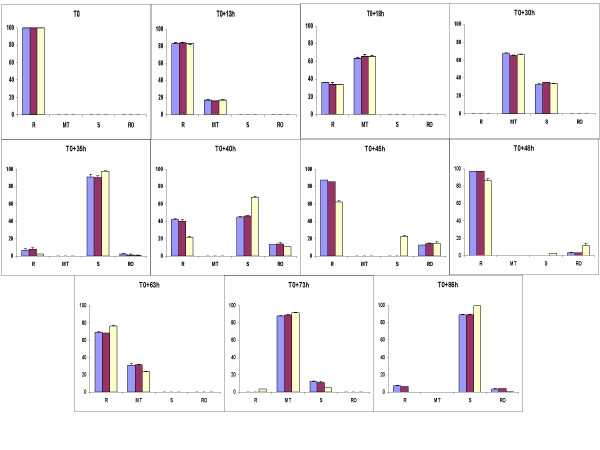
Percentages evolution of asexual stages of synchronous culture of 3D7 Plasmodium falciparum clone under different oxygen tensions during 86 hours. Each percentage represents the mean ± standard deviation of three experiments. R: Ring. MT: Mature Trophozoïte: S: Schizont. RO: Rosace. Blue histograms correspond to 5% O2; Purple histograms correspond to 10% O2. Yellow histograms correspond to 21% O2.